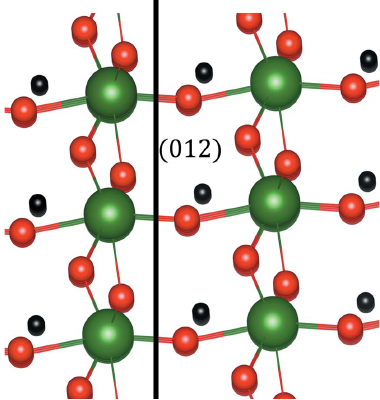
Figure 19 The structure of LiNbO 3 viewed along the (012) plane. The [012]* reciprocal lattice direction is horizontal. Table 14 Cleavage energies in LiNbO 3 (obtained from an experiment) against the length of the structural gaps calculated in this